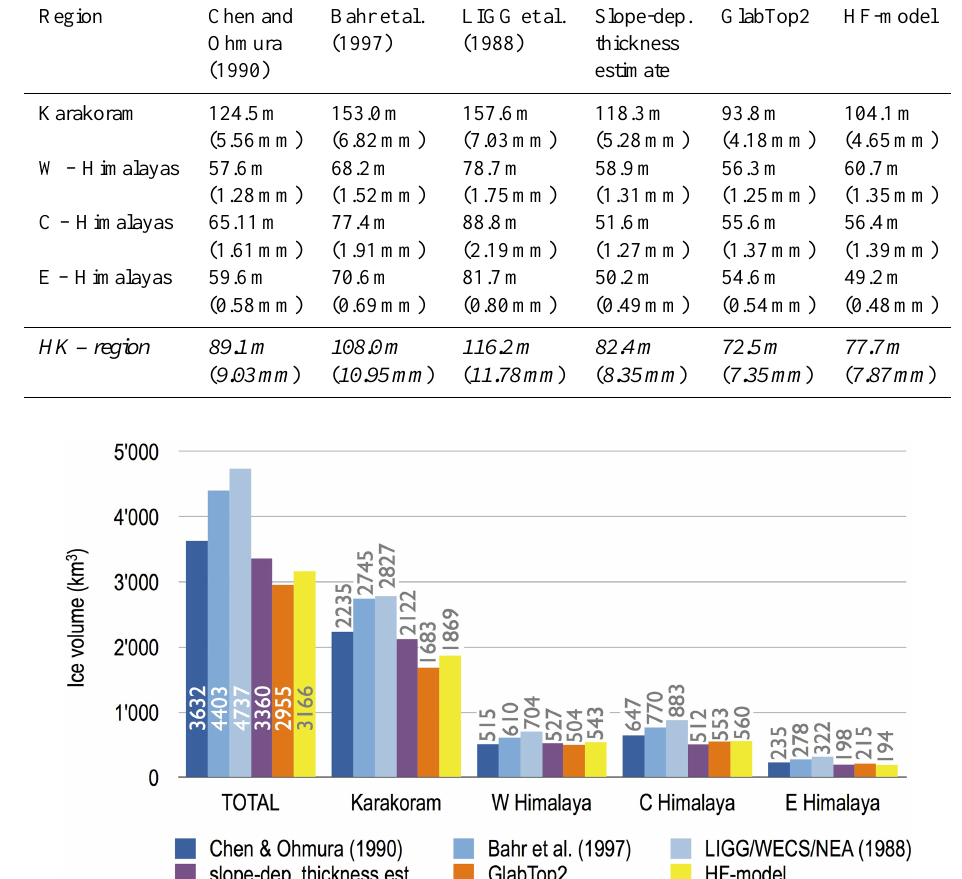
Figure 5. Resulting volumes (km 3 ) for the entire HK region (left) and the four